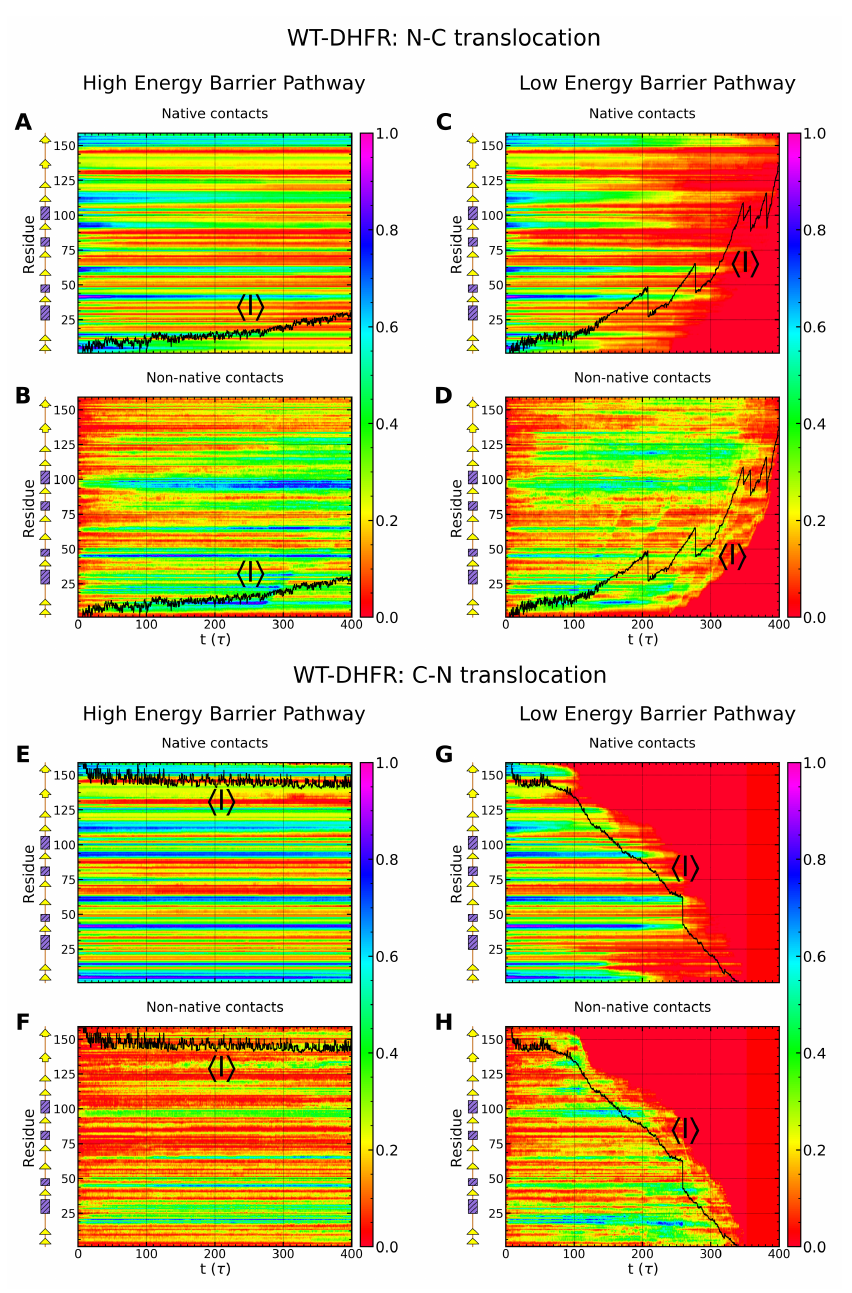
Figure 8. Direction-dependent time evolution of native and non-native content of wild-type DHFR. ( A – D ) The time-dependent fraction of native Q N and non-native f NN contacts formed by secondary structural elements of wild-type DHFR during translocation in the N-C direction in the ( A , B ) high- and ( C , D ) low-energy barrier pathway. ( E – H ) Same as in ( A – D ) in C-N translocation. The time- dependent average translocation line (black) is also